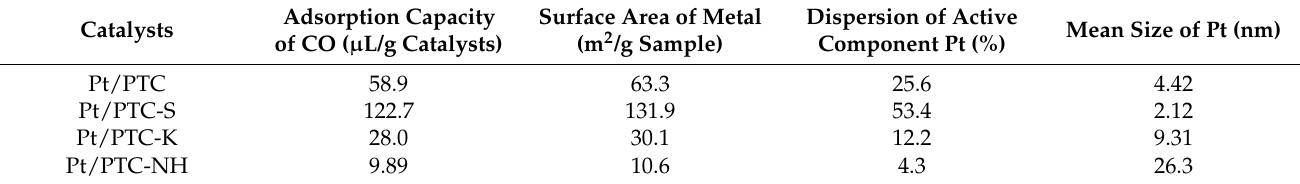
Table 2. The dispersion degrees of active component Pt particles in the Pt-loaded catalysts.